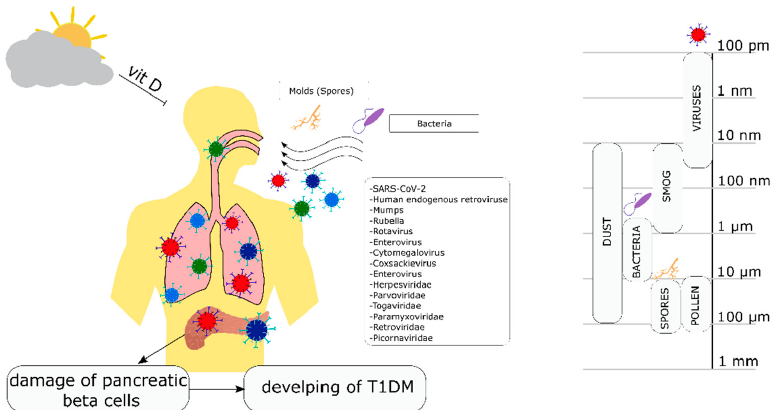
Figure 1. The possible influence of environmental factors on the risk of developing type 1 diabetes mellitus.